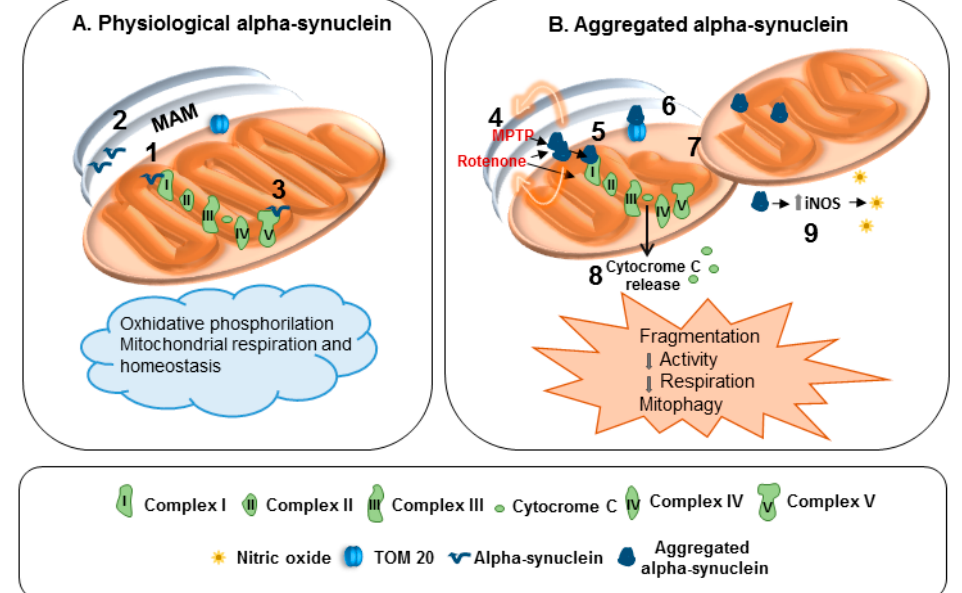
Figure 1. Effects of physiological and aggregated α -synuclein on mitochondria. ( A ) 1: α -Synuclein controls protein targeting and mitochondrial morphology. 2: Interaction with mitochondria-associated ER membranes (MAM). 3: Interaction with adenosine triphosphate (ATP) synthase. ( B ) 4: Inhibitory action of 1-methyl-4-phenyl-1,2,3,6-tetrahydropyridine (MPTP) and Rotenone on complex I is fostered by α -synuclein. 5: Complex I dysfunction. 6: Impaired mitochondrial protein import. 7: Mitochondrial fragmentation and mitophagy. 8: Release of cytochrome C. 9: Upregulation of inducible nitric oxide synthase (iNOS) and nitric oxide generation.